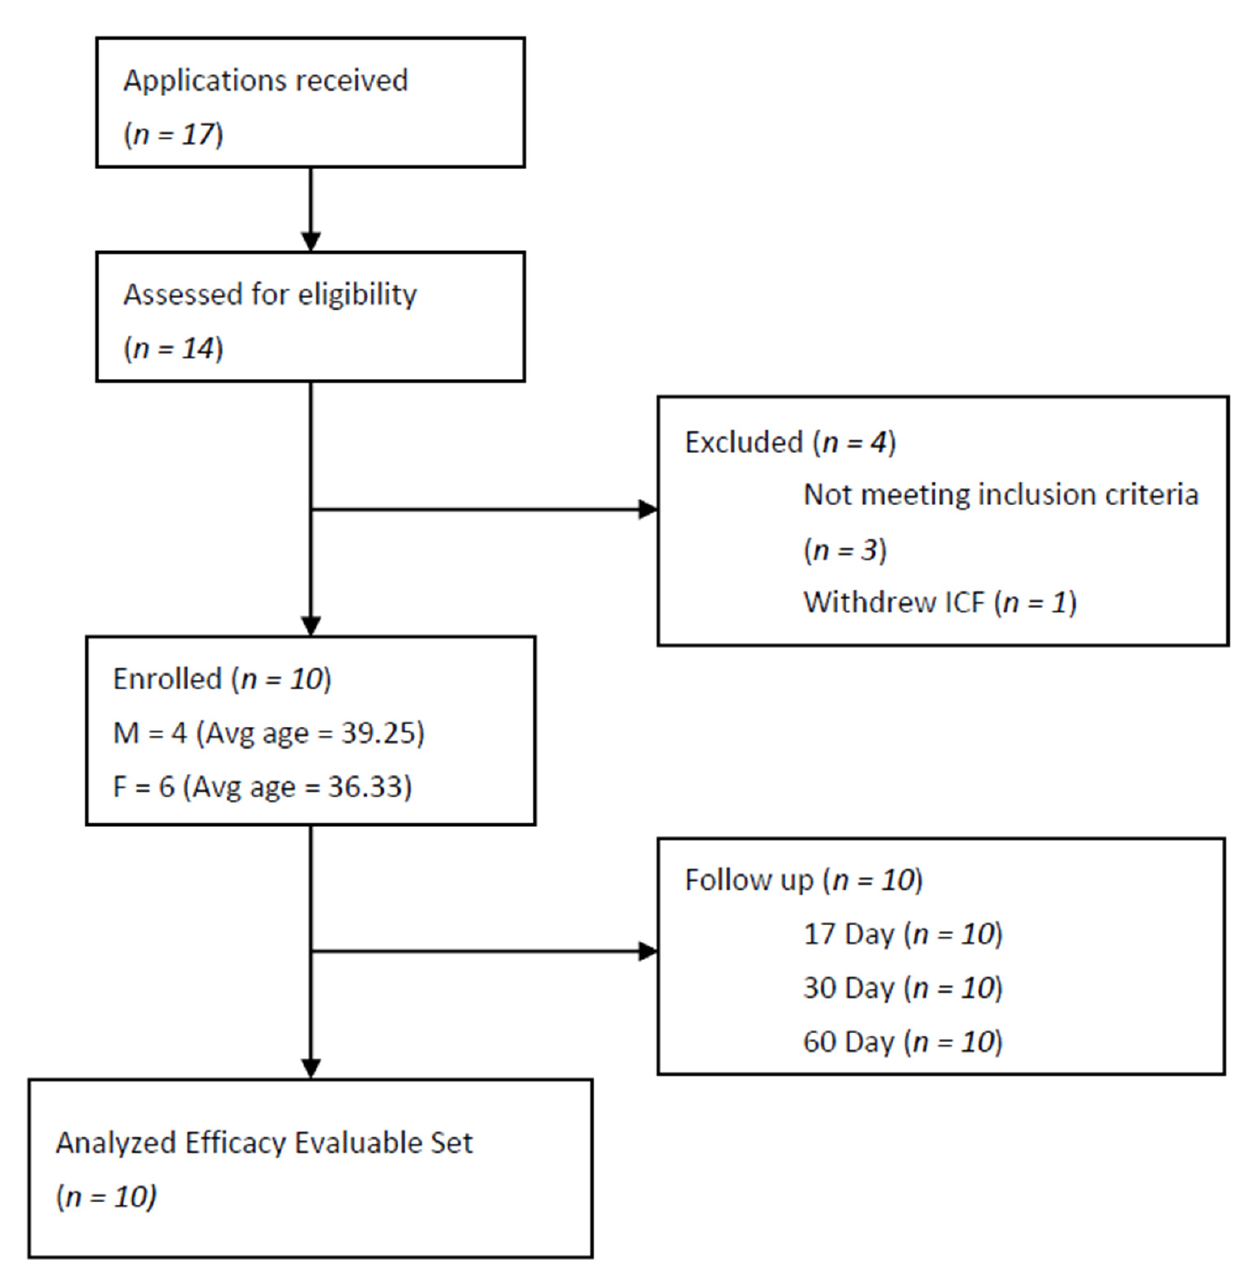
Figure 1. Flow chart of an open-label, homeopathic pathogenetic trial for safety and the evaluation of the immune response of BiosimCovex in healthy volunteers. ICF = Informed Consent Form . Table 1 . Demographics of Individual Subjects .